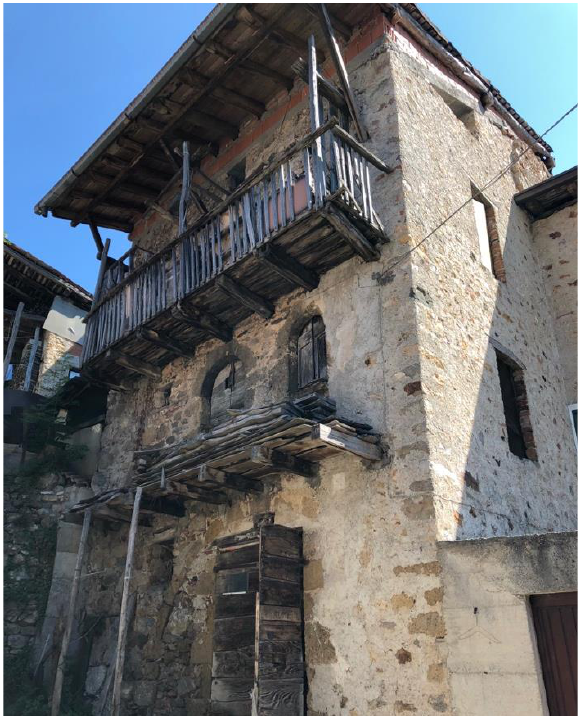
Figure 1. Farmhouse in Magno di Bovegno, Brescia (Italy)